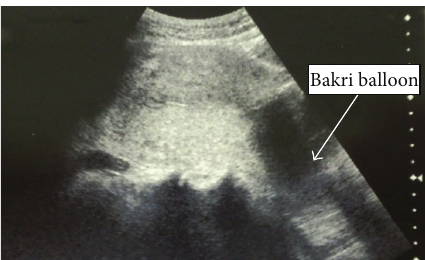
Figure 3: The uterine fundus was again pushed up with a balloon containing 400 mL of physiological saline. The uterus was com- pletely reduced and the hemorrhage was